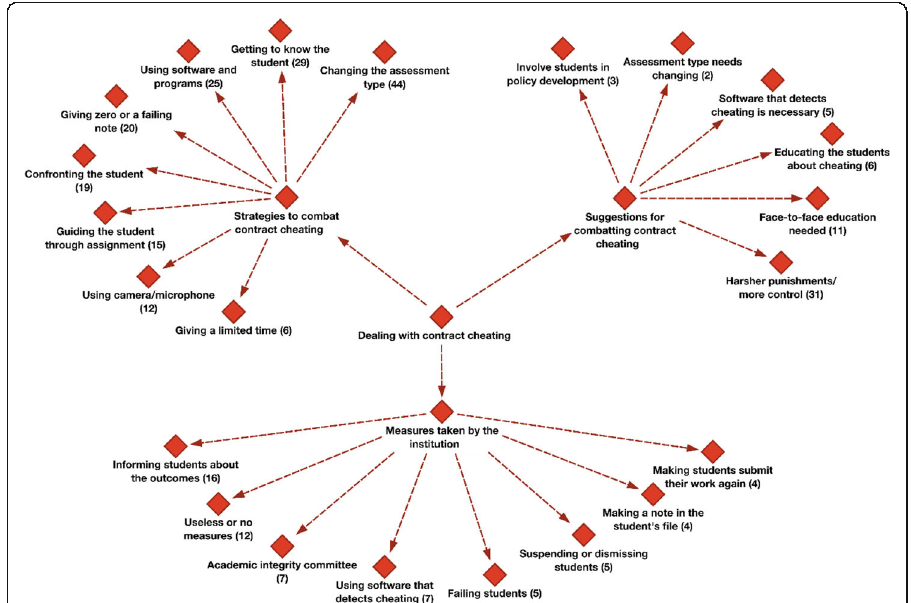
Fig. 3 Dealing with contract cheating hierarchical code-subcodes model and frequencies